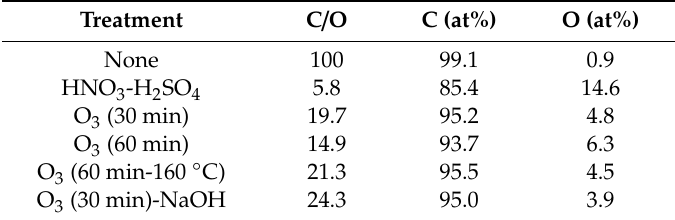
Table 2. Carbon and oxygen content (at%) of CNTs treated with HNO 3 -H 2 SO 4 , O 3 and O 3 -NaOH. Treatment C / O C (at%) O (at%) None